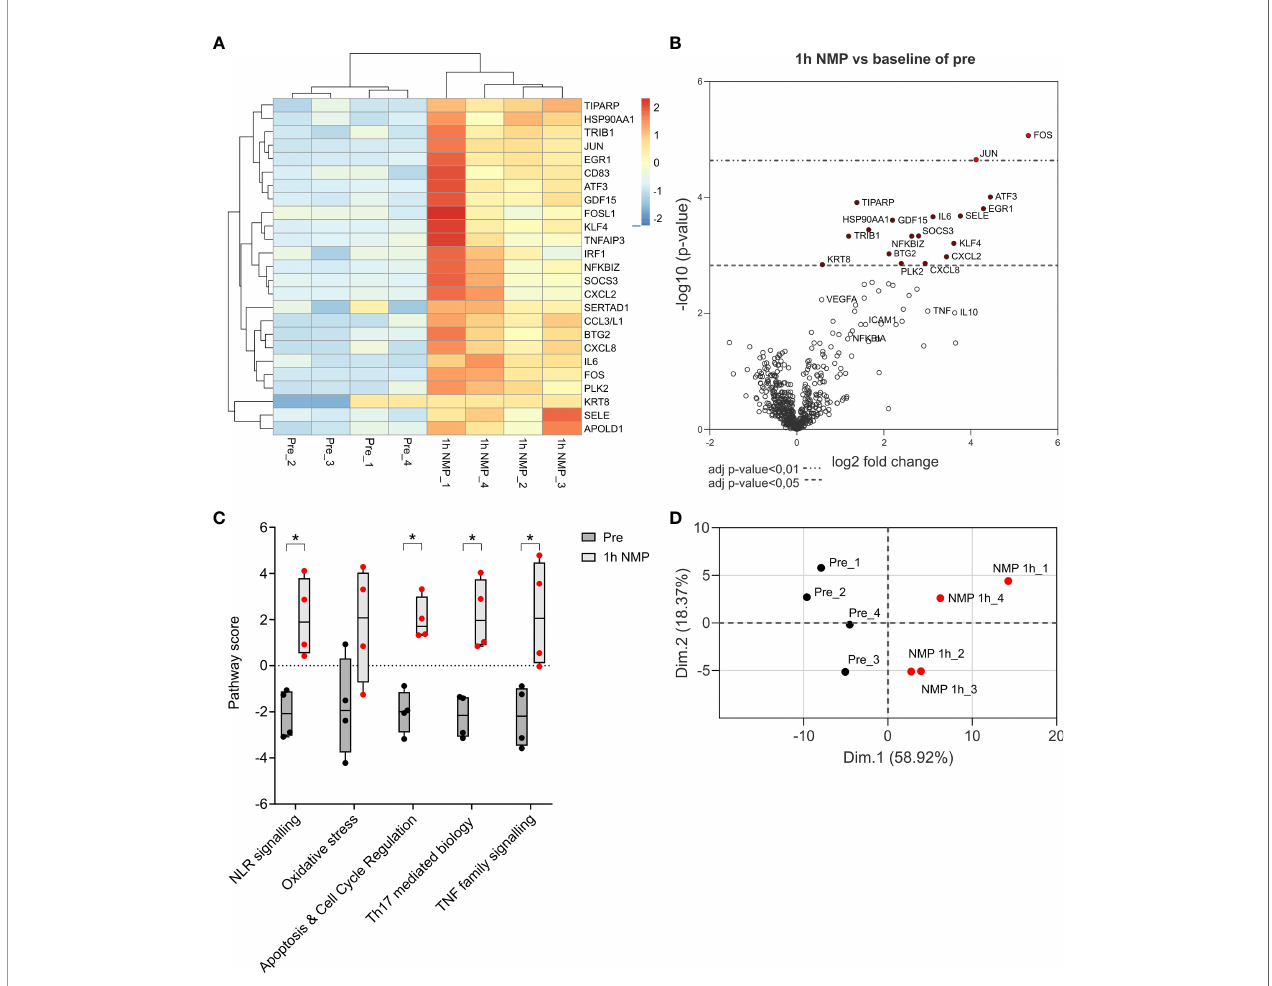
FIGURE 3 | Nanostring nCounter Organ Transplant Panel analysis of 4 cortex samples of kidneys comparing transcriptional analysis of differential expressed genes after 1h NMP compared to baseline pre samples. Total RNA was isolated and processed. (A) Heatmap of the top 25 signi fi cantly differentially expressed genes. (B) Volcano plot represents differential gene expression after 1h NMP. Difference in gene expression level with p-value adjusted <0.01 or <0.05 are marked by red dots. (C) Top 5 pathways up-regulated after NMP. Statistical signi fi cance was calculated by Mann Whitney test (*, p<0.05). (D) Principal component analysis on the top 100 differentially expressed genes.